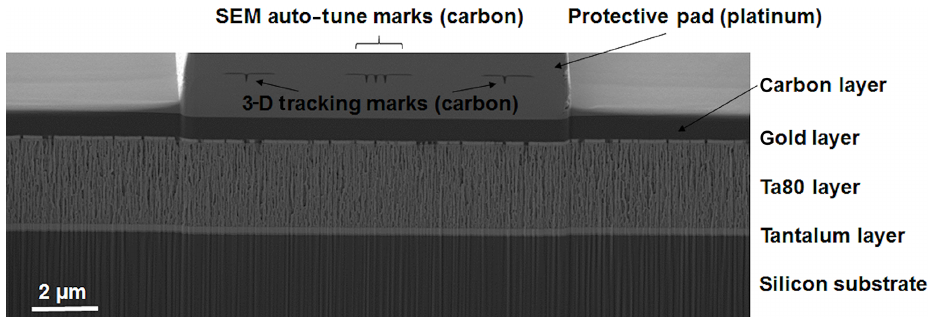
Figure 2. Setup for the automated SEM/FIB experiments exemplified by sample Ta80.